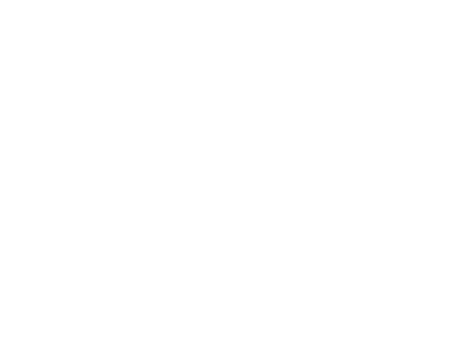
Table 1. Dimensions of the whole system and some parameters.